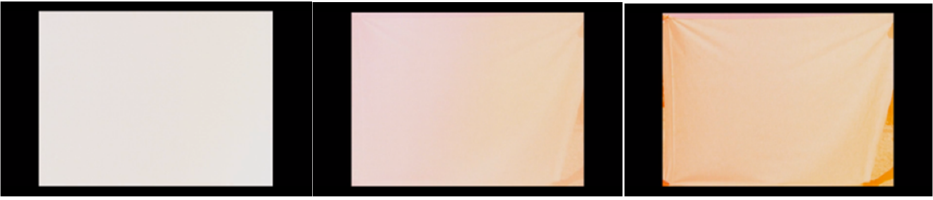
Figure 1. Footnotes to a House of Love